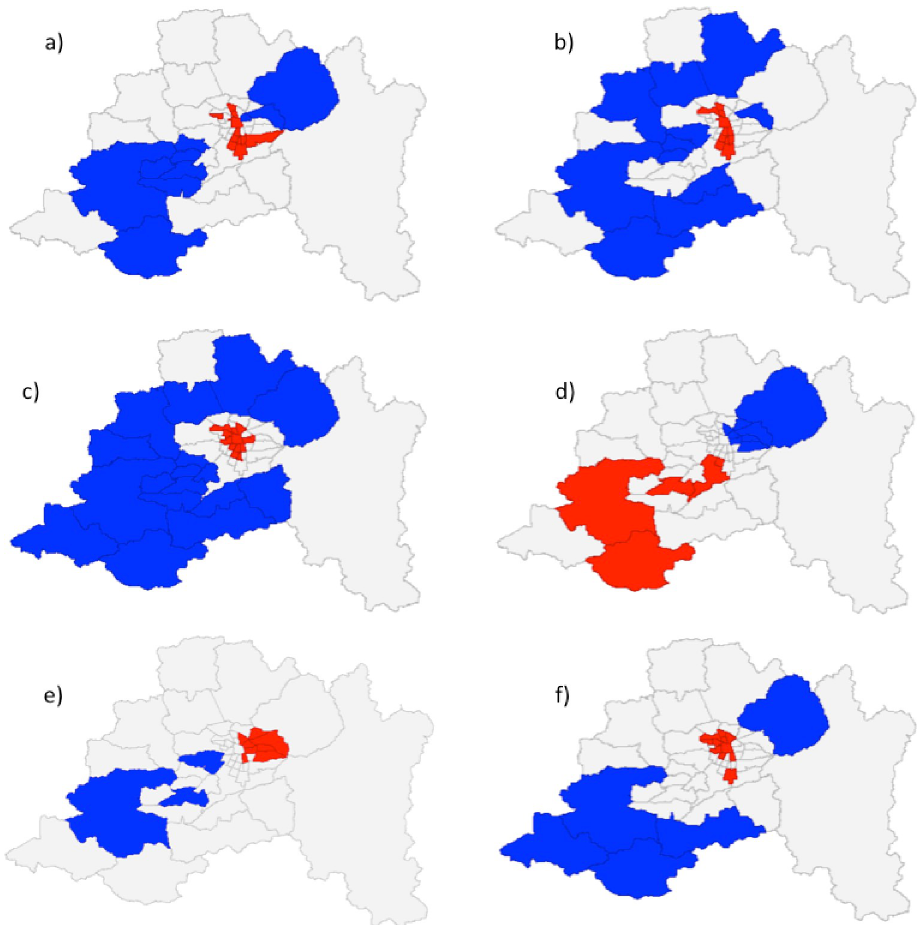
Fig 2. G i � tests for clustering in selected variables. (a) infections (100 days cumulative rate); (b) deaths (100 days cumulative rate); (c) population density; (d) public health insurance; (e) average years of education; (f) use of public transportation. Blue: low-value clusters (95% significance); Red: high-value clusters (95% significance); Grey: not significant areas.